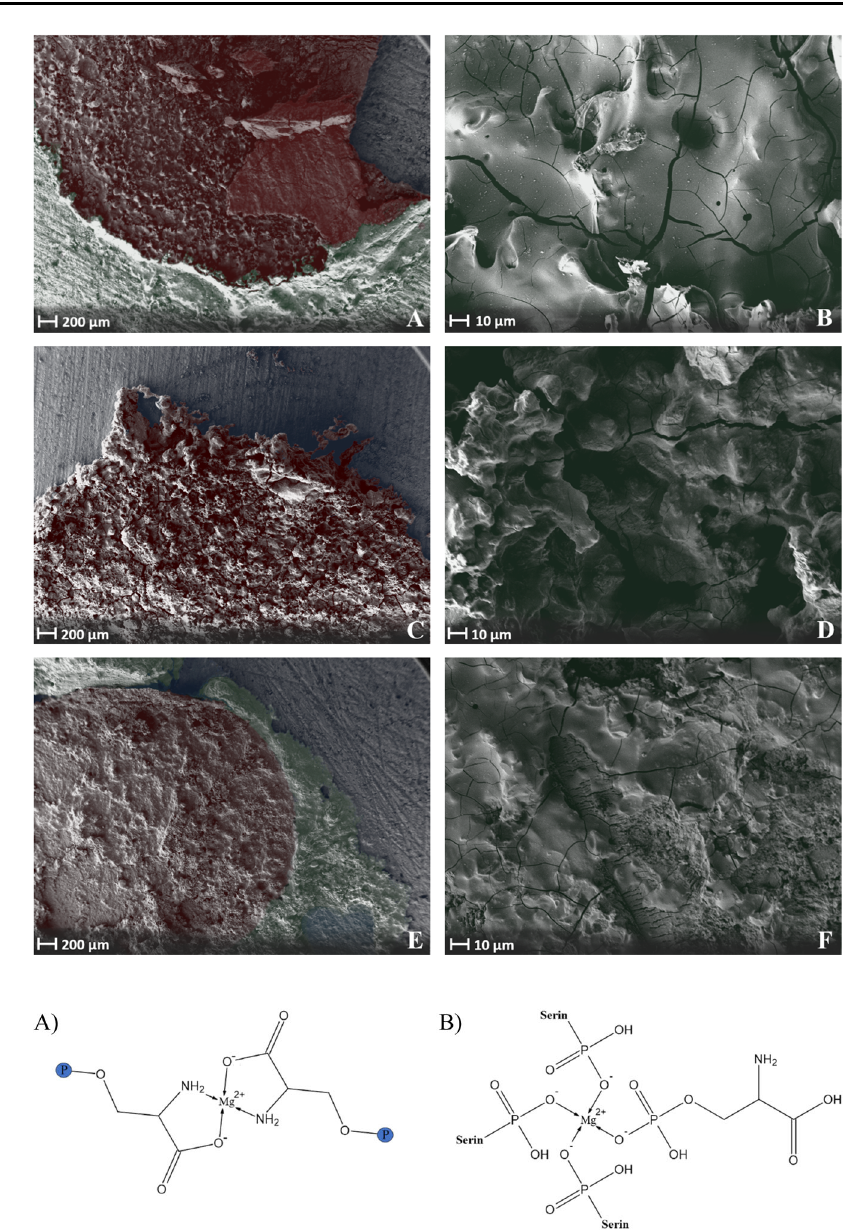
Fig. 9 Conceivable con fi gurations for coordinative bonds of phosphoserine with Mg 2 + : A Coordinative bonds between Mg2 + and amino or carboxyl groups. B Coordinative bonds between Mg 2 + and phosphoryl